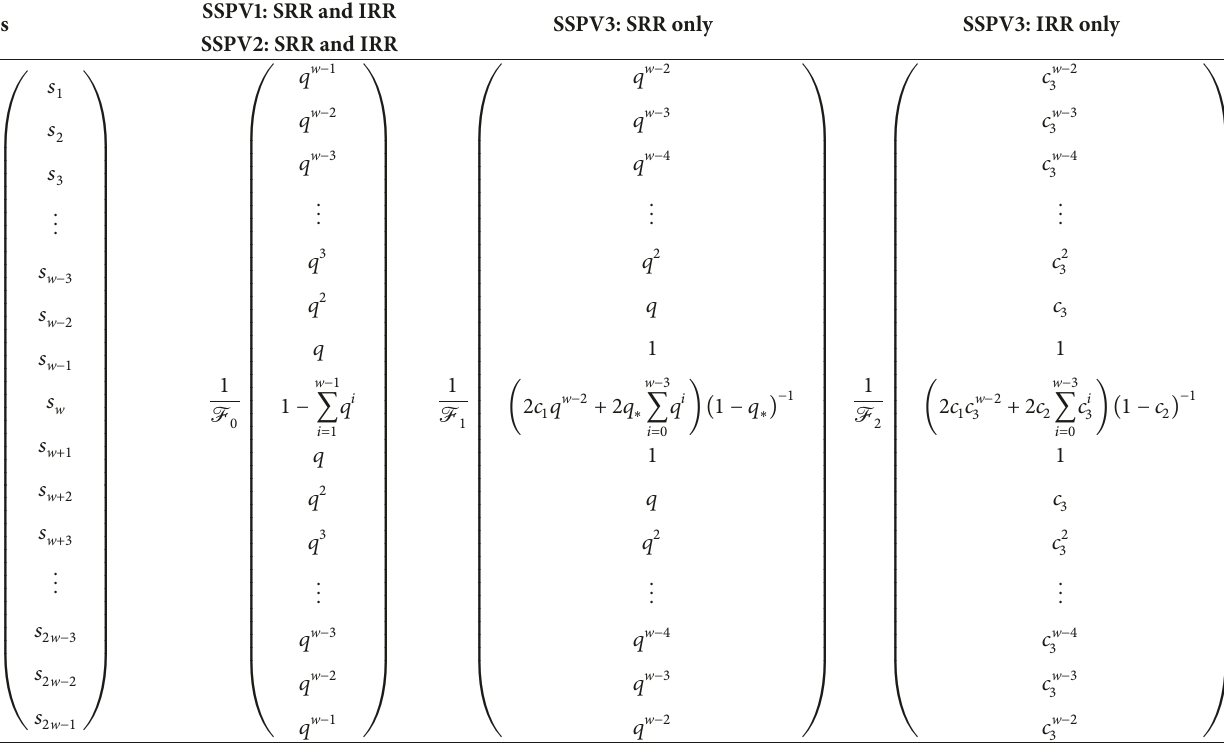
Table 11: The steady-state initial probability vectors of the two-sided SS w-of-w SRR and IRR schemes.